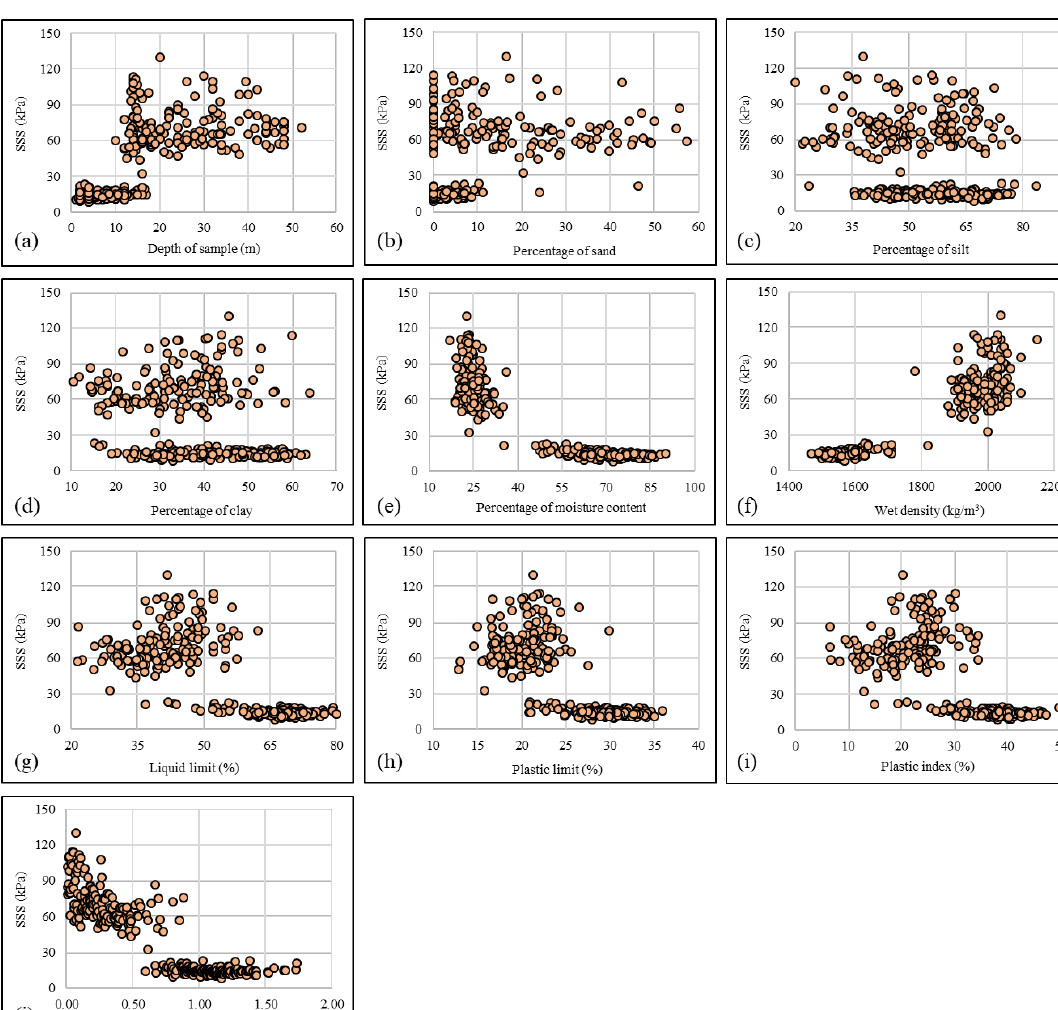
Figure 4. The relationship between shear strength and the input variables; ( a ): depth of sample, ( b ): percentage of sand, ( c ): percentage of silt, ( d ): percentage of clay, ( e ): percentage of moisture content, ( f ): wet density, ( g ): liquid limit, ( h ): plastic limit, ( i ): plastic index, and ( j ): liquidity index.